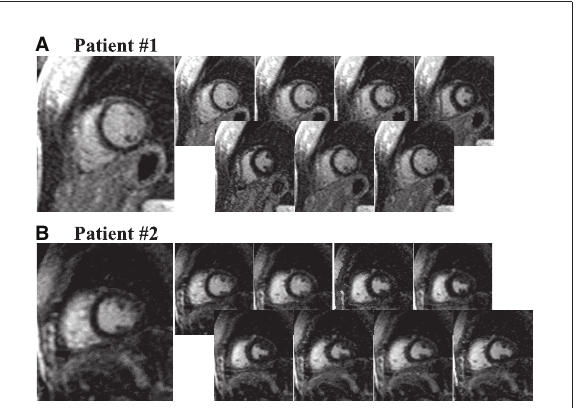
FIGURE5 Functional LGE images acquired in LGE negative patients at 1.5T with 80 ms temporal resolution. Compared with 3T visually increased noise is depicted in the 1.5T images due to reduced baseline SNR at this lower field strength, and later acquisition time after contrast injection. While, consistent nulling of the myocardium is achieved and the blood-pools remain clearly depicted. (A) Seven cardiac phases were obtained in this patient with a heart rate of 73 bpm. (B) Eight cardiac phases were acquired in this subject with 77 bpm heart